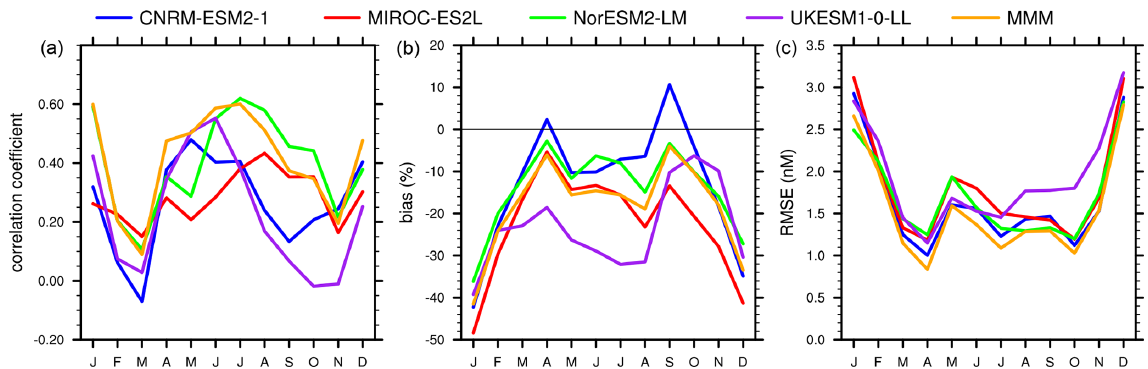
Figure 4. Monthly mean statistics of surface ocean DMS concentration. (a) Spatial correlations between a model and L11, (b) biases (in percentage of L11), and (c) RMSE (nM). A 0% bias line is drawn for visual aid. Model diagnostics are shown as in Fig. 1. The values are provided in Table S1 in the Supplement. The same metrics computed against G18 and W20 are plotted in Fig.